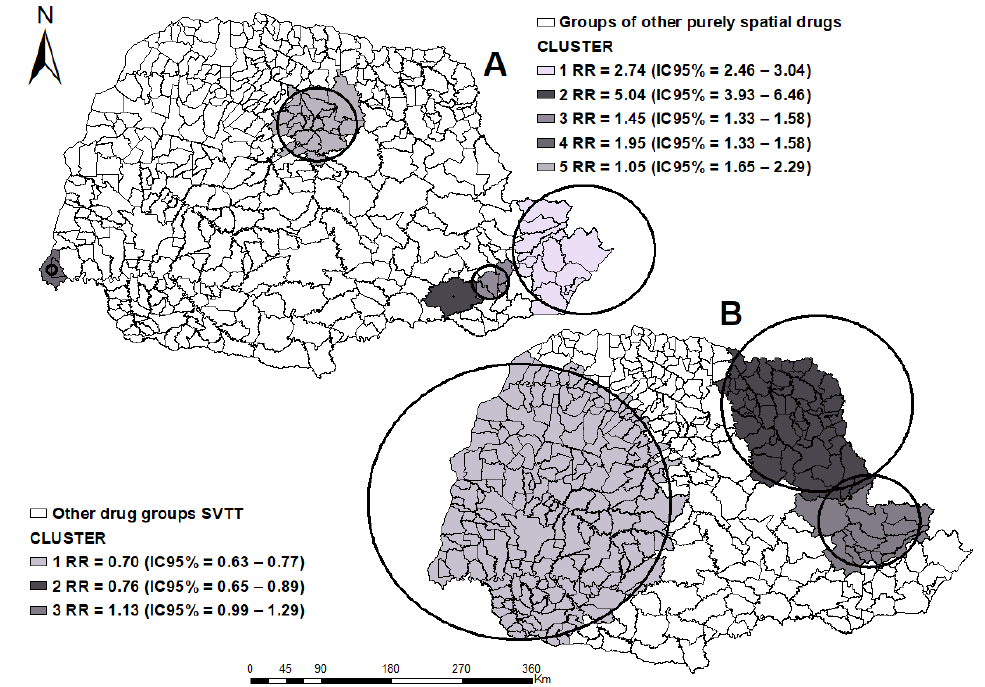
Figure 4. Areas of spatial risk for tuberculosis in users of other drugs, by municipalities, state of Paraná (2008–2018). ( A ) applied the purely spatial technique; ( B ) applied the purely Spatial Variation in Temporal Trends. Legend: ArcGIS [GIS software]. Version 10.0. Redlands, Califórnia, EUA: Environmental Systems Research Institute, Inc., 2010. As shown in Figure 4B, the SVTT analysis for TB and other drugs identified two protection clusters and one at-risk cluster. The protection Cluster 1 reached the entire length of the Western, Northwest, Western Center, South, and Southwest mesoregion, with ITT = 36.7% of annual growth and ETT = 16.3% of growth per year, and Cluster 3 in the Metropolitan mesoregion of Curitiba, ITT of 37.3% and ETT of 18.5% annual growth. Cluster 2 of risk is located on the boundary between the Pioneer North and Central Oriental mesoregions, with ITT of 70.8% annual growth and ETT of 35.7% of growth per year. 4. Discussion The study aimed to identify Hotspots of people diagnosed with tuberculosis and abusive use of alcohol, tobacco, and other drugs in communities through a geospatial intelligence application. According to the results, Hotspots were identified according to the type of drug used by people with TB; this may be associated with the social determinants of the different regions and/or territories identified. We found spatial variations in the temporal trends of alcohol, tobacco, and other drugs, showing that the phenomenon is growing in this territory. The incidence of TB cases associated with alcohol, tobacco, and other drugs was also verified, with a heterogeneous distribution between the state’s different regions. TB is historically known for its direct relationship with social determinants in health and for reaching the most vulnerable population groups, a factor that requires an individualized, collective, and programmatic health strategy for its elimination [17].